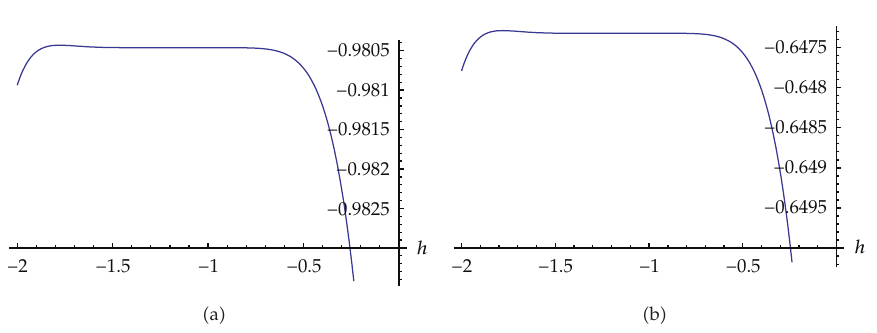
Figure 3: (cid:2) a (cid:3) The h curve of system (cid:2) 1.2 (cid:3) for u (cid:2) 5 , 1 (cid:3) obtained from the 10th order HAM. (cid:2) b (cid:3) The h curve of system (cid:2) 1.2 (cid:3) for v (cid:2) 5 , 1 (cid:3) obtained from the 10th order HAM.